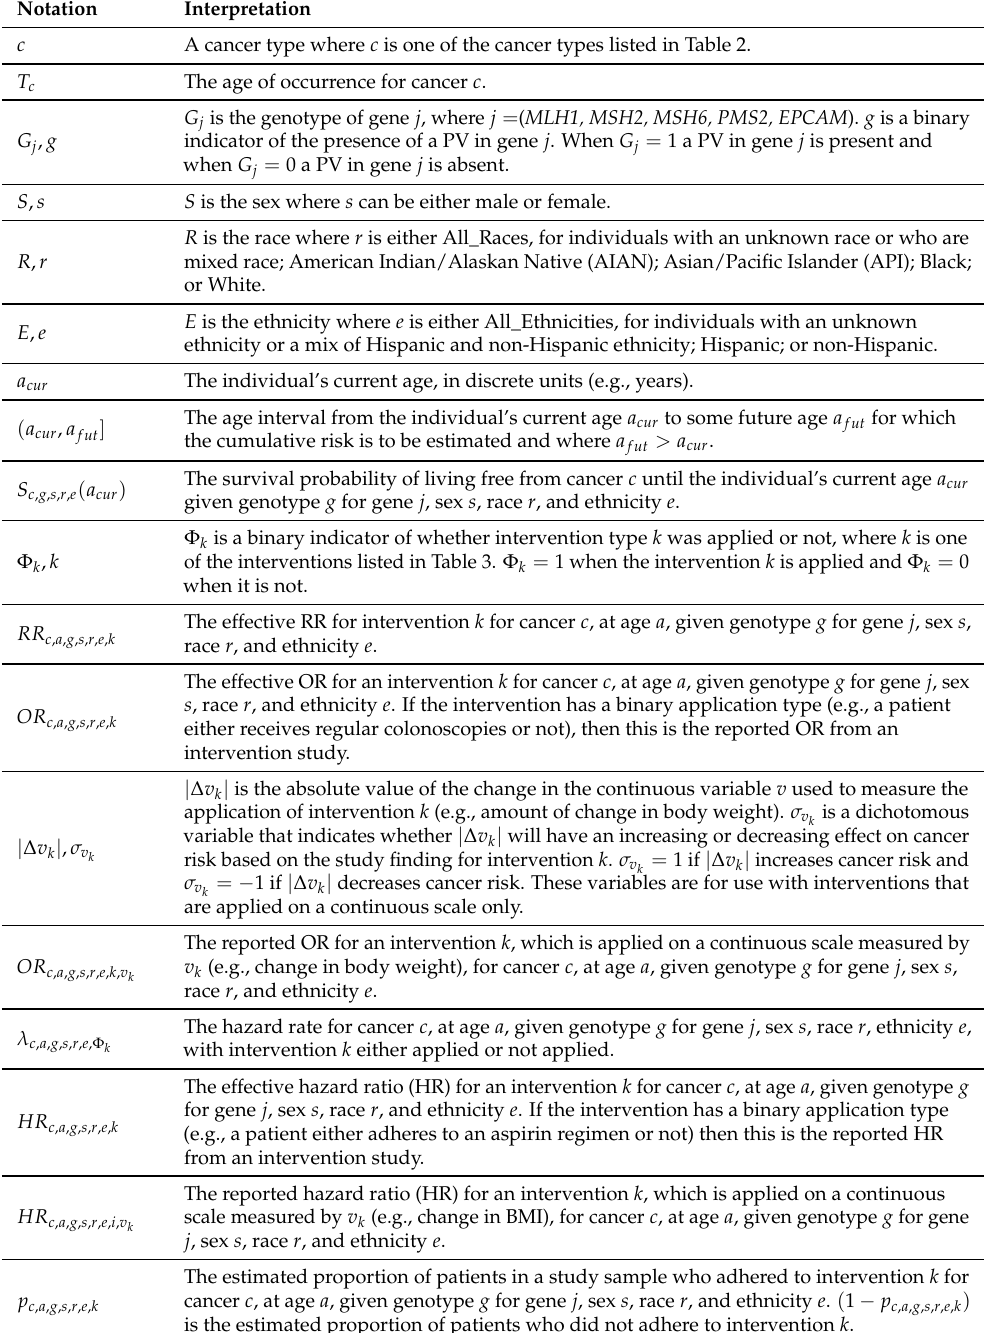
Table 1. Notation used to describe our approach to the calculation of risk, considering one cancer type at a